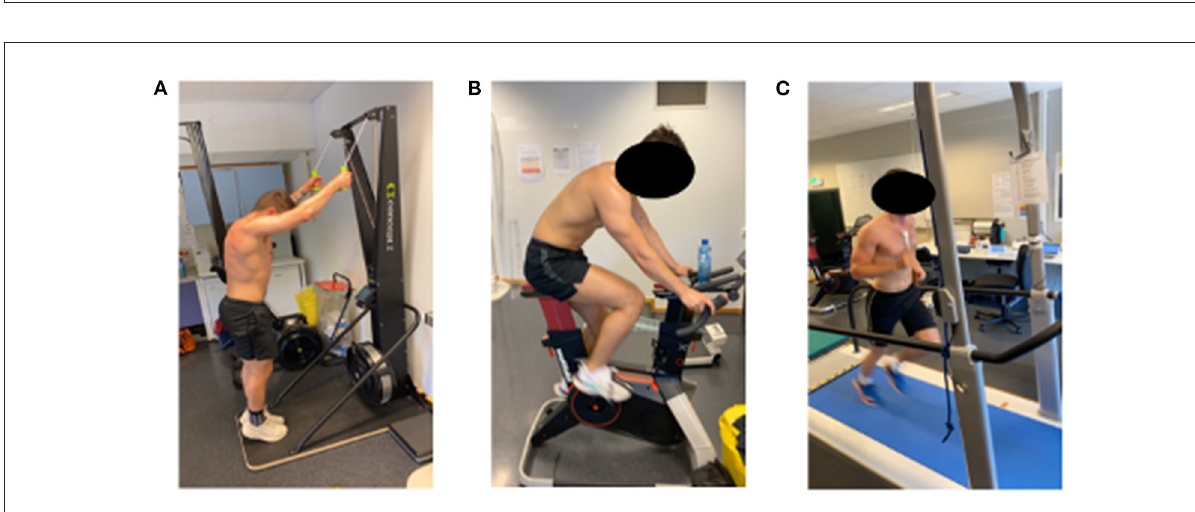
FIGURE4 Laboratory exercise modalities evaluated during preliminary testing of ECG24 sensor: (A) Ski double-poling, (B) Cycling, (C) Running.